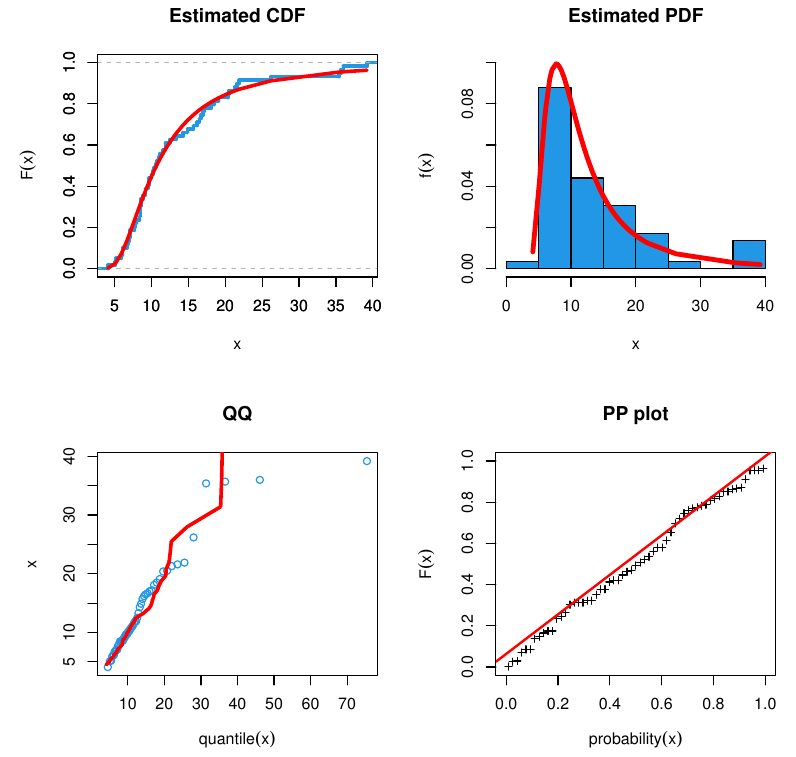
Figure 12. Estimated pdf, estimated cdf, PP and QQ plots for FB distribution for second